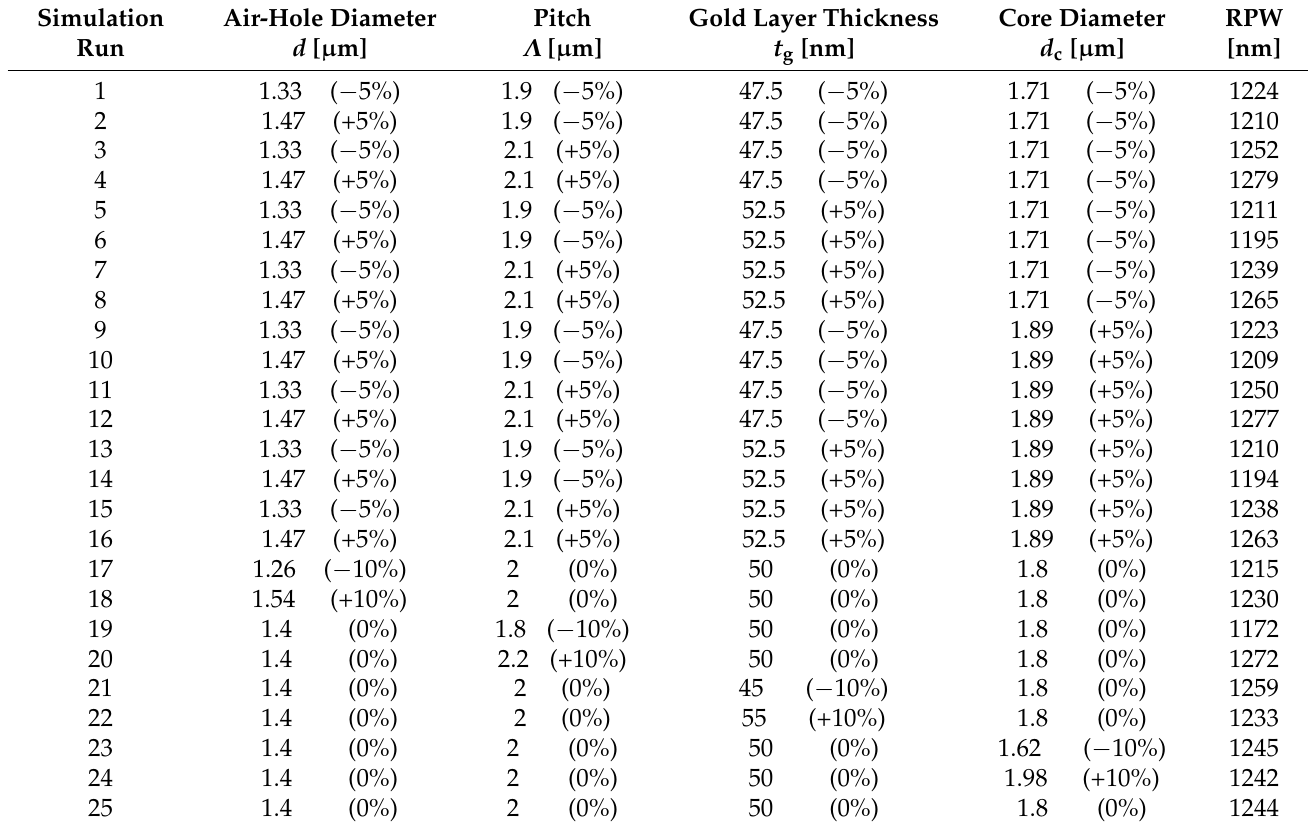
Table 9. FEM Simulations for Five-Level 4-Parameter ( ± 10% variations) CCD Analysis. Simulation